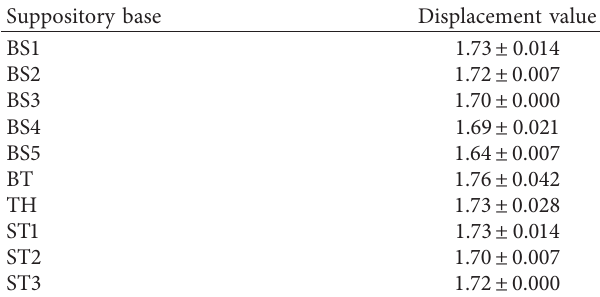
Table 3: Displacement values of alum (Aw) in the base. Suppository